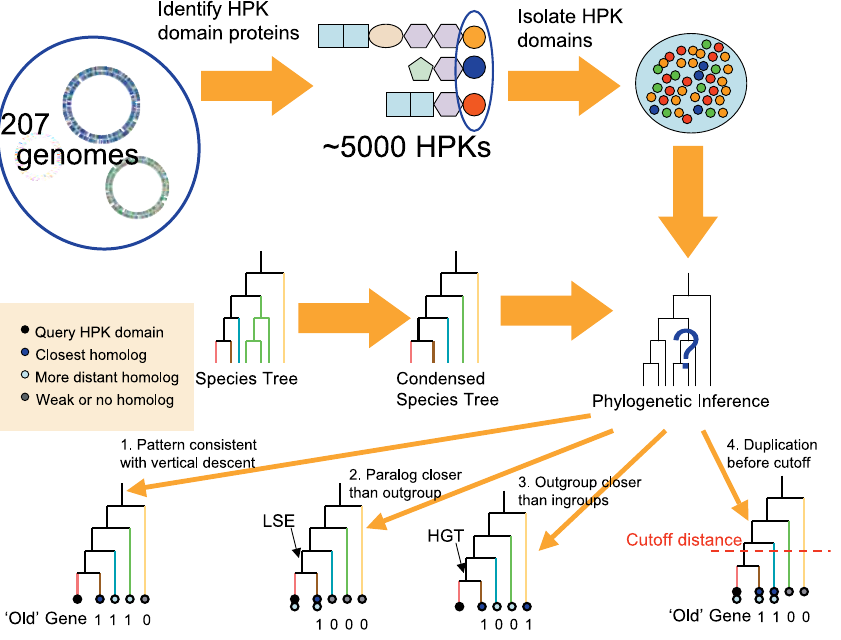
Figure 1. Overview of Approach An overview of our phylogenetic inference procedure is given. We look only at histidine kinase domains from HPKs, and compare the distribution of these to the species tree. When homologs in distant outgroups are more distantly related, we infer simple vertical descent. Paralogs and distances that contradict species phylogeny result in our inference of gene duplication or horizontal transfer. Only events (such as duplication or transfer) that occurred more recently than the cutoff as described in the Methods are considered. Four hypothetical cases are shown, and each is labeled as present/ absent ( ‘‘ 1 ’’ or ‘‘ 0 ’’ ) from each outgroup according to the procedure described in the Methods.